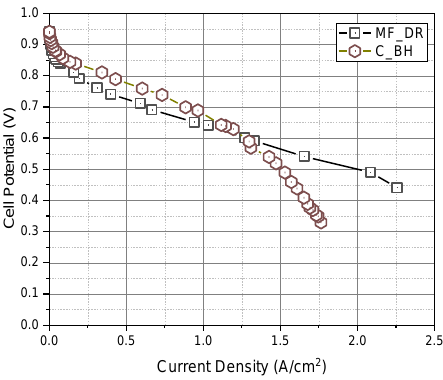
Figure 8. Comparison of PEFC voltage variations with channel under BH and metal foam under DR humidification conditions.